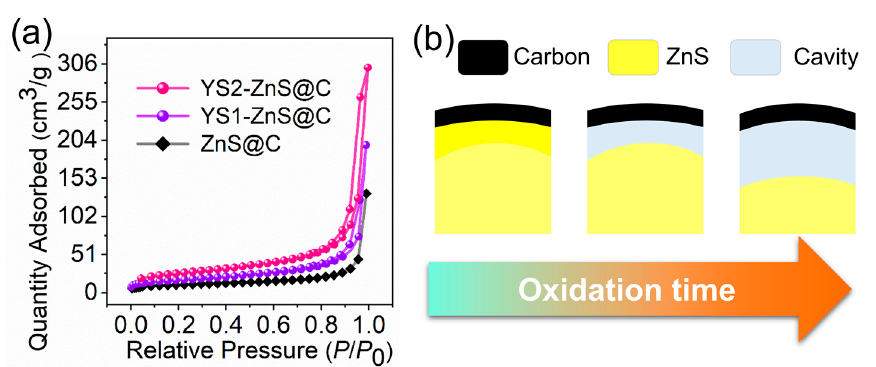
Figure 4. ( a ) Nitrogen adsorption-desorption isotherms of ZnS@C, YS1-ZnS@C and YS2-ZnS@C. ( b ) Schematic of controlling size of cavity of materials by oxidation time.